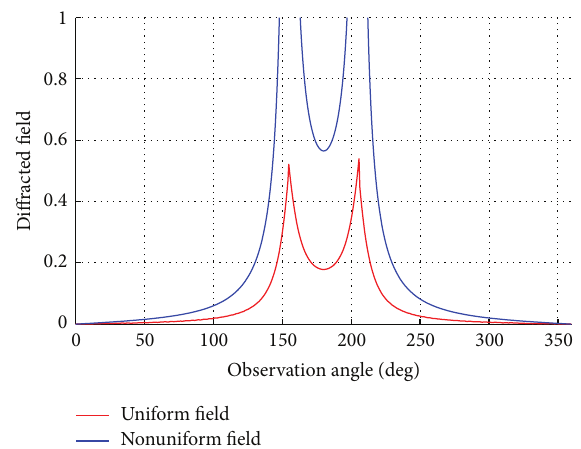
Figure 2: The nonuniform solution at 𝜙 0 = 𝜋/7 .